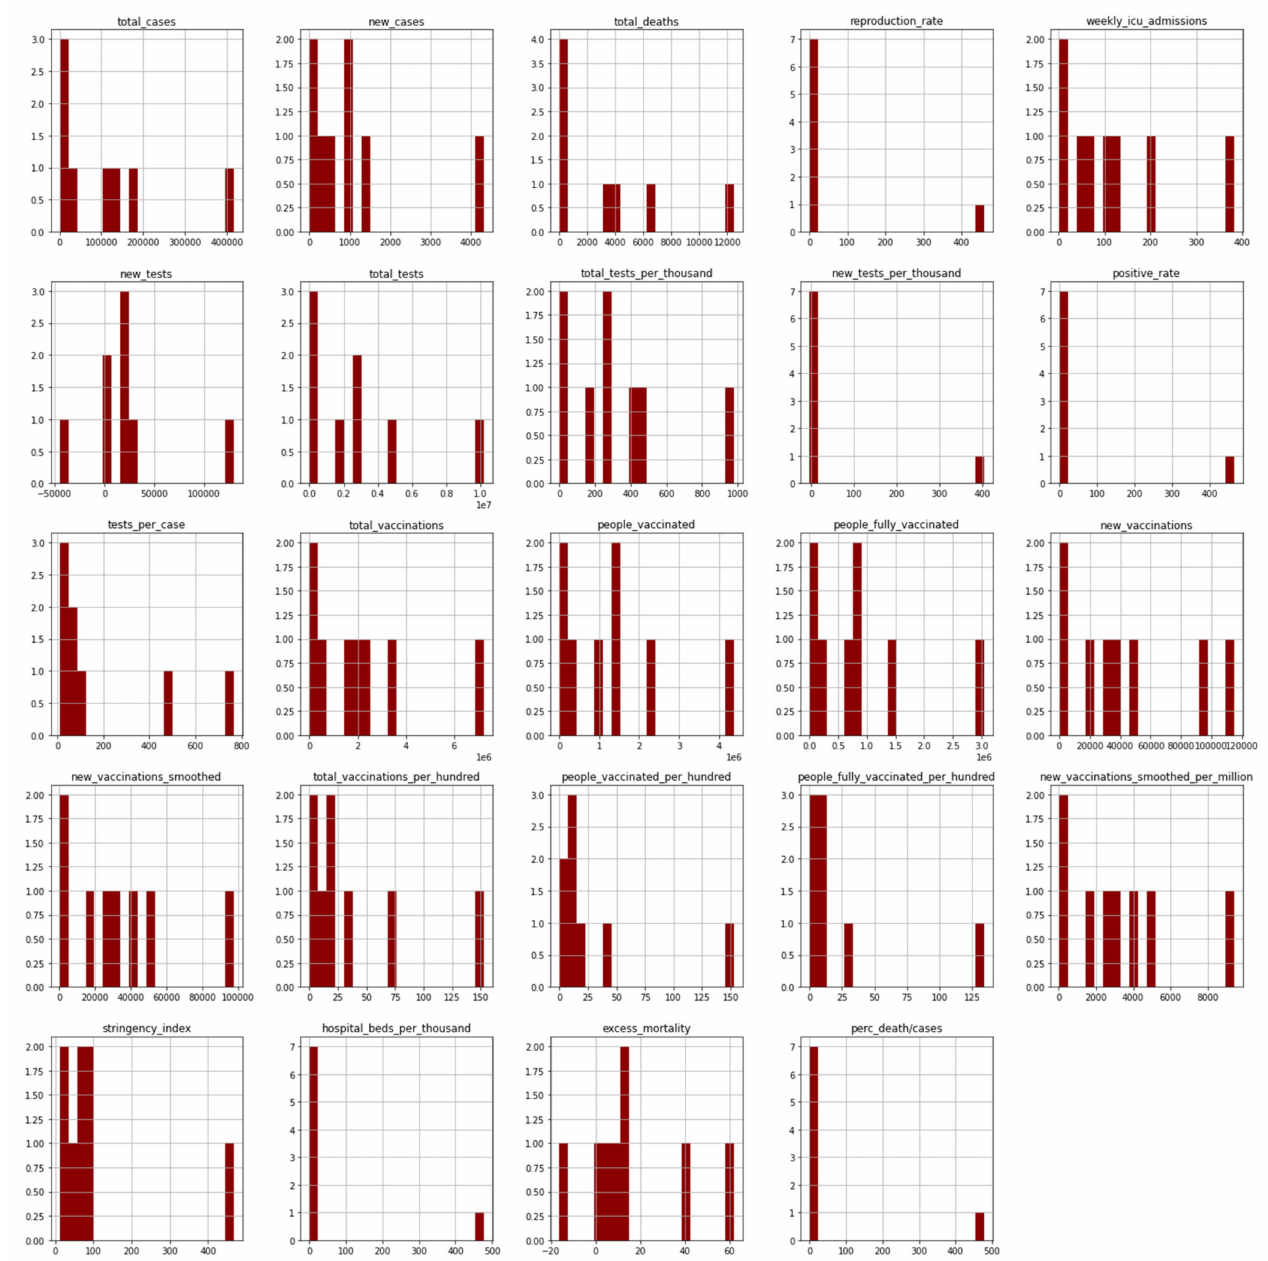
Figure 6. Pandemic statistical analysis of